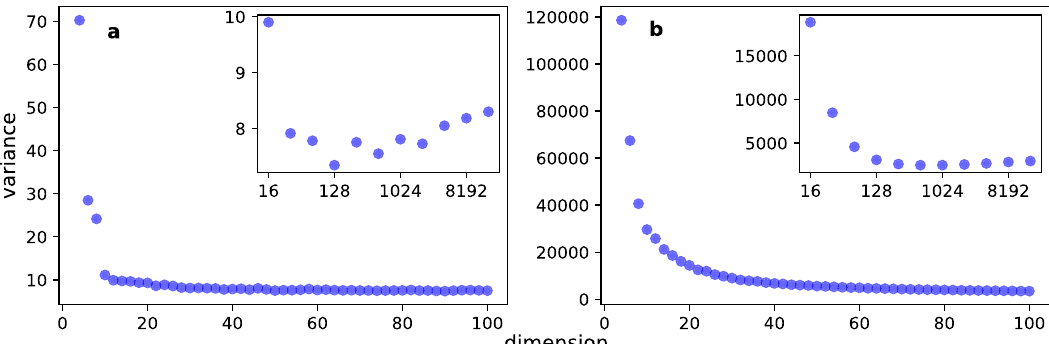
Fig. 5 Embedding variance in real networks. a Variance as a function of the embedding dimension d . Results are valid for node2vec embeddings of the American college football network. b Same as in panel a, but for the Cora citation network. A similar analysis has been performed for other real-world networks, see Supplementary